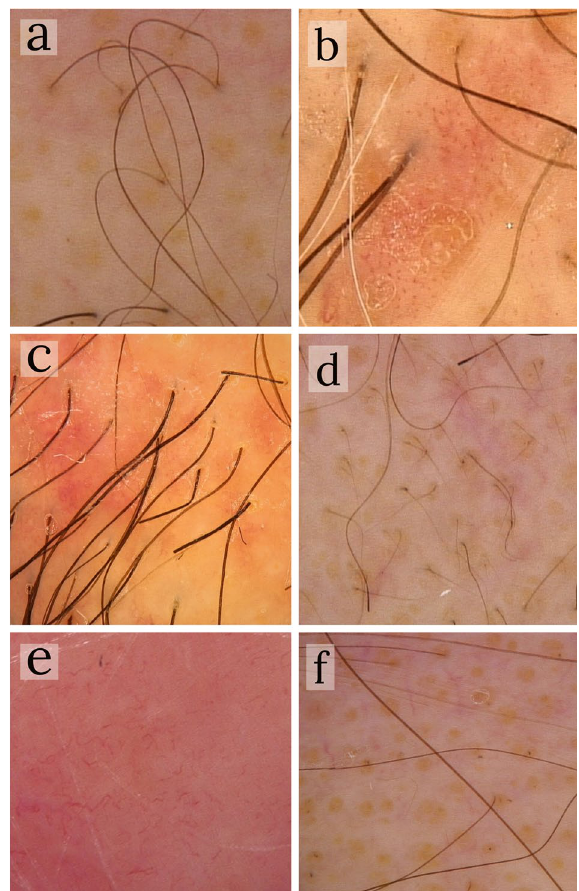
Figure 2. The 6 most frequent trichoscopic features in Folliculotropic Mycosis Fungoides patients. ( a ) single hairs (× 10); ( b ) dotted dilated vessels (× 50); ( c ) broken-dystrophic hairs (× 50); ( d ) vellus hairs (× 10); ( e ) spermatozoa-like pattern vessels (× 50); ( f ) yellow-dots (×